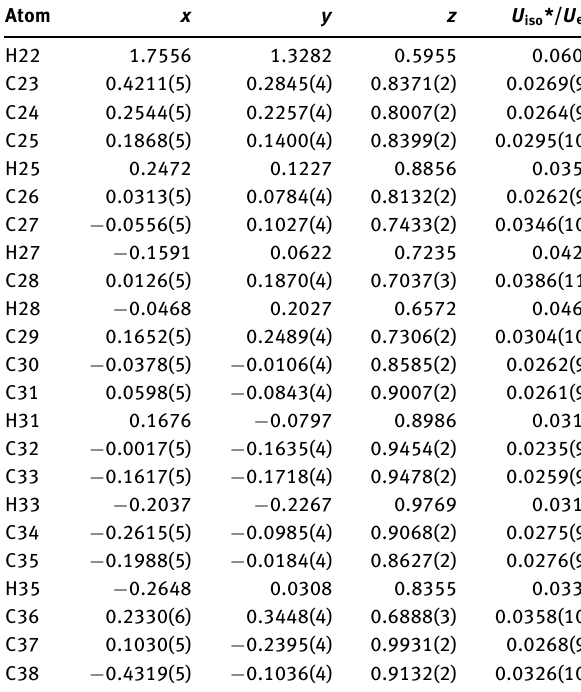
Table 2: Fractional atomic coordinates and isotropic or equivalent isotropic displacement parameters (Å 2